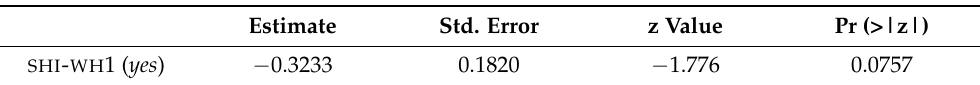
Table 13. Mean acceptability ratings in sub-experiment 4.